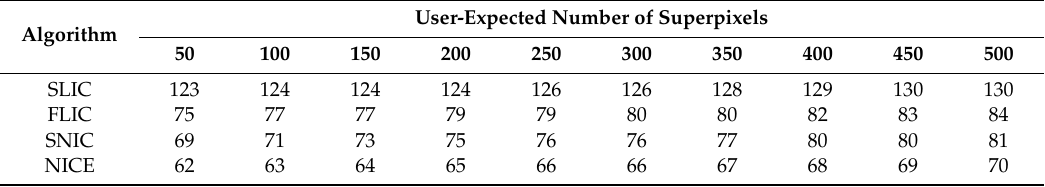
Table 5. Comparison of four algorithms in terms of ET (msec) on NYUv2.